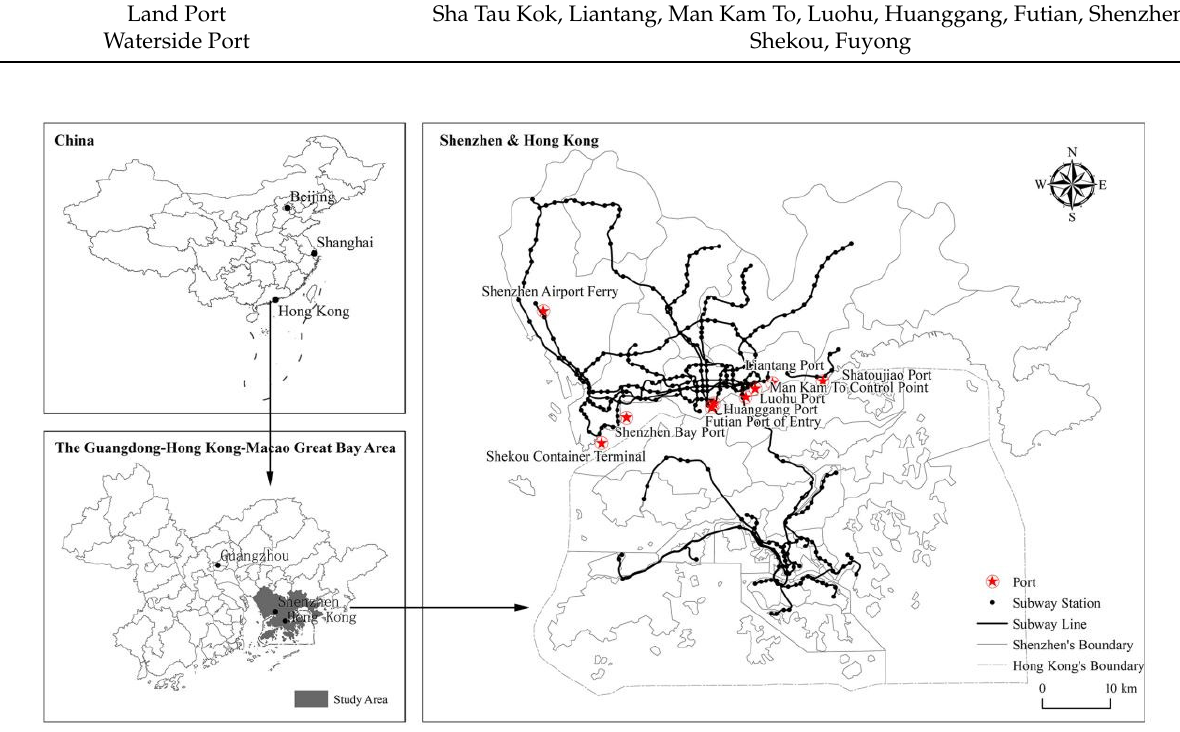
Figure 1. Geographical location of the Shenzhen–Hong Kong port and subway network. Note: The map is based on the standard map of the Map Technical Review Centre of the Ministry of Natural Resources of China (Number: GS (2019)4342), with no modifications to the base map; Map-making by author.